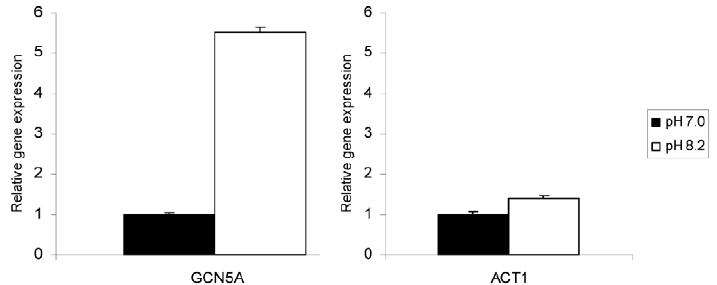
Figure 1. TgGCN5-A mRNA is up-regulated in response to alkaline stress. Wild-type (WT) parasites were incubated in control (pH 7.0) or alkaline media (pH 8.2) for three days. The levels of mRNA expression for TgGCN5-A or ACT1 were monitored by quantitative real-time PCR. Gene expression relative to control is shown. Error bars indicate the S.D.